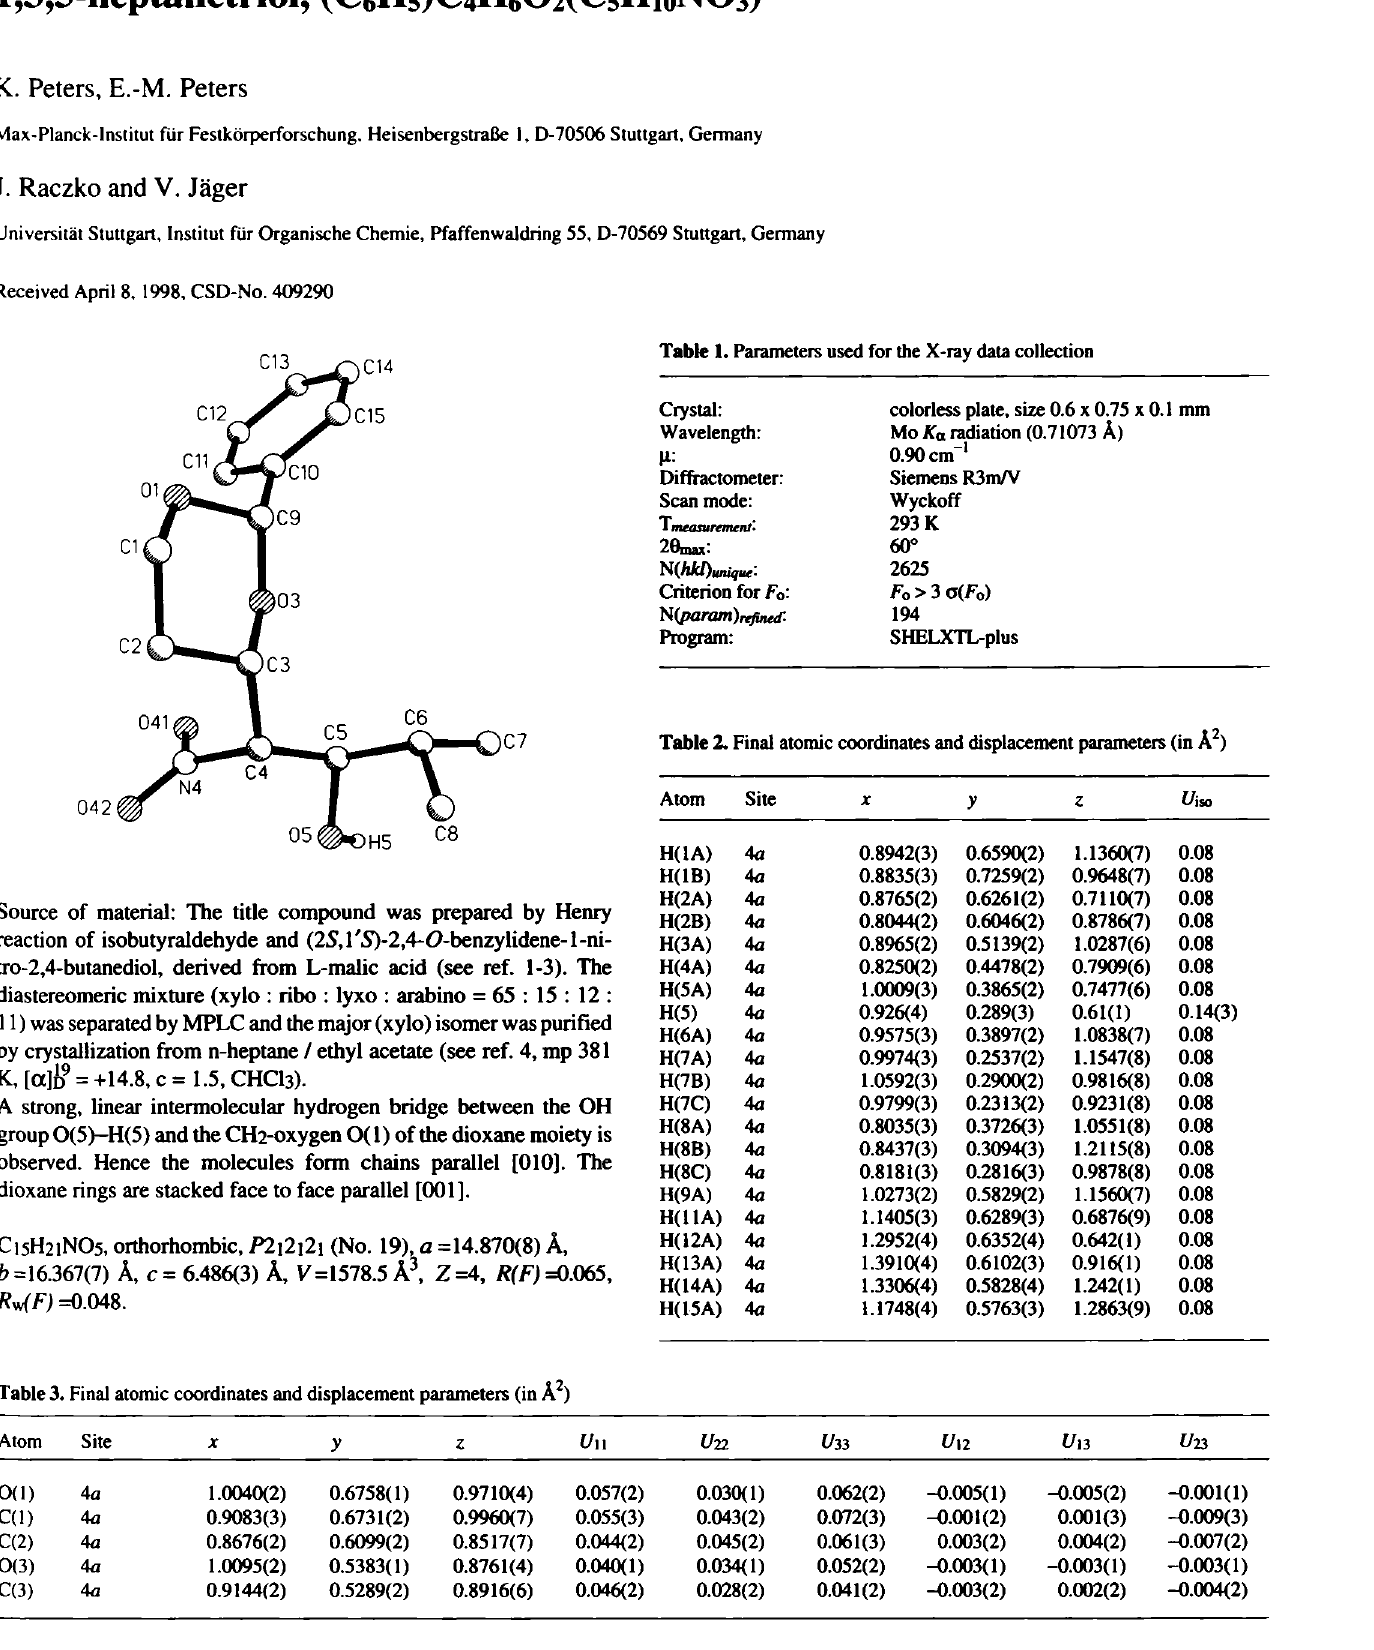
Table 1. Parameters used for the X-ray data collection Crystal: